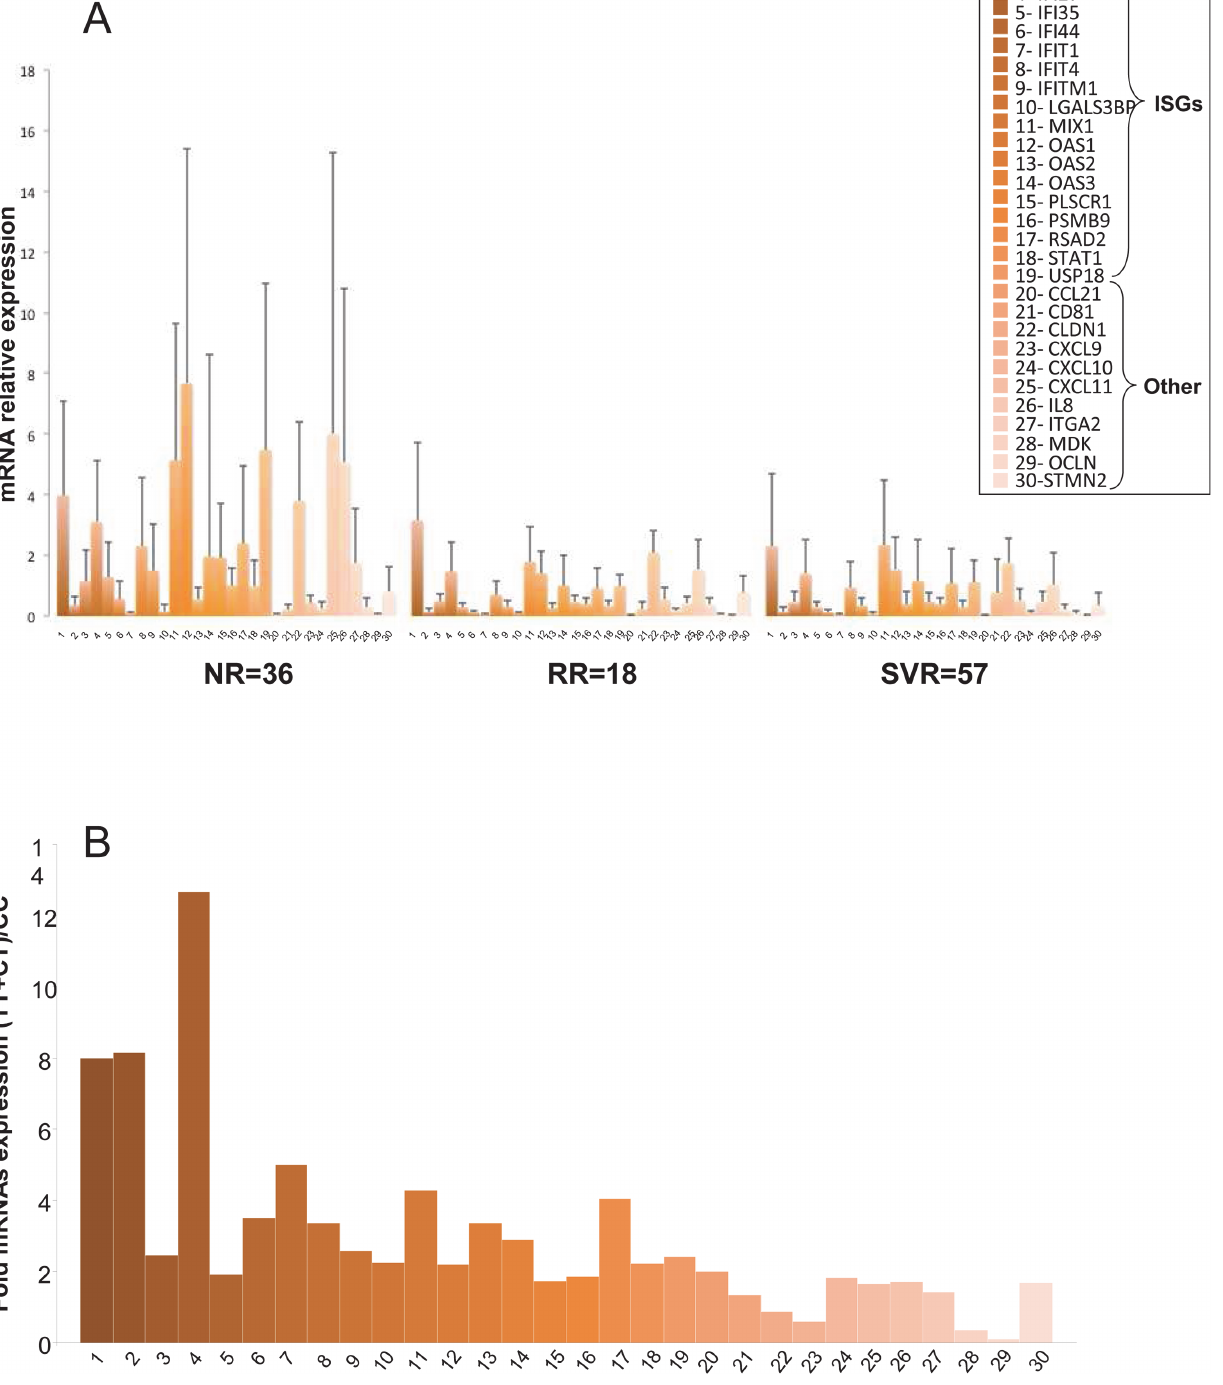
PLOS ONE | DOI:10.1371/journal.pone.0121395 April 6,